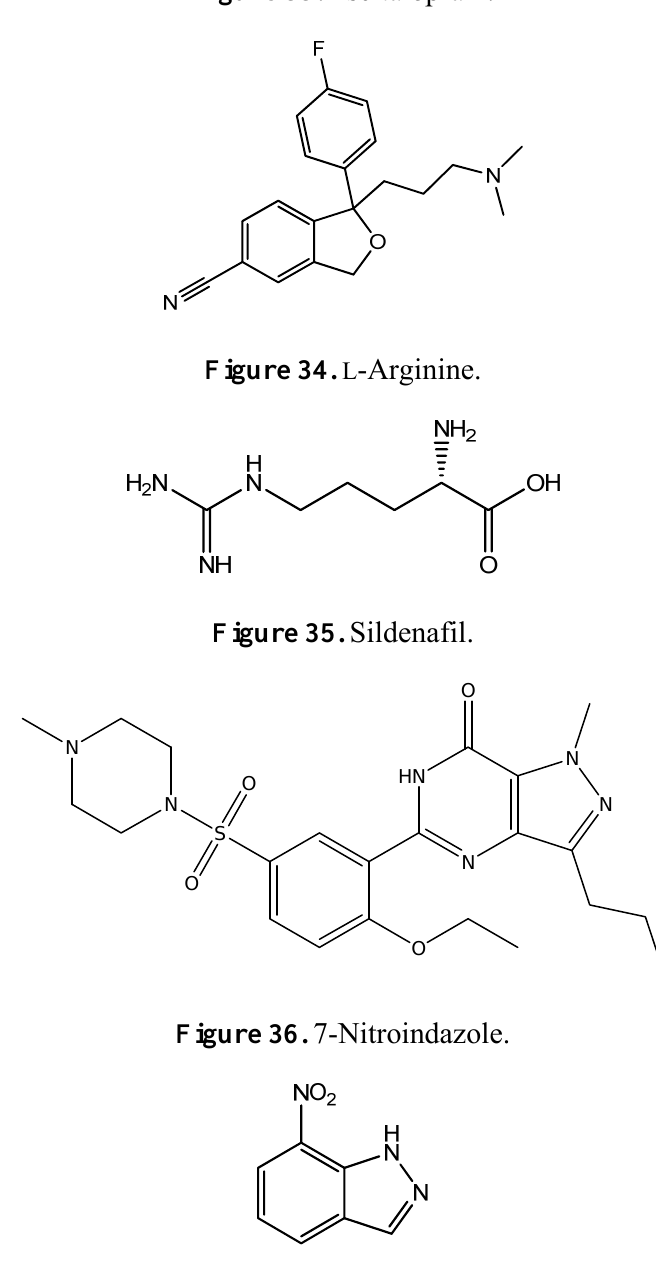
Figure 33. Escitalopram.